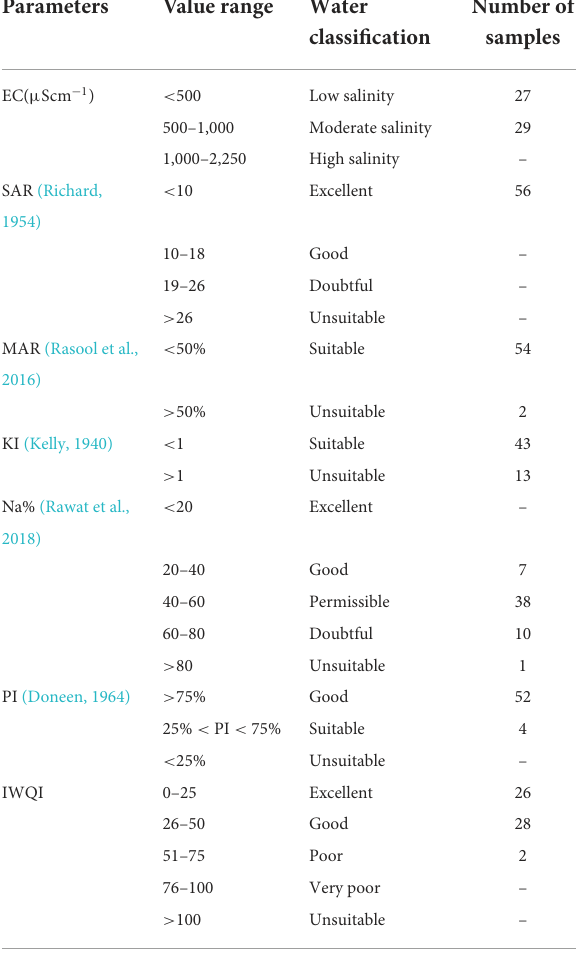
TABLE 5 Representing the irrigation indices determining the suitability of groundwater for agriculture.